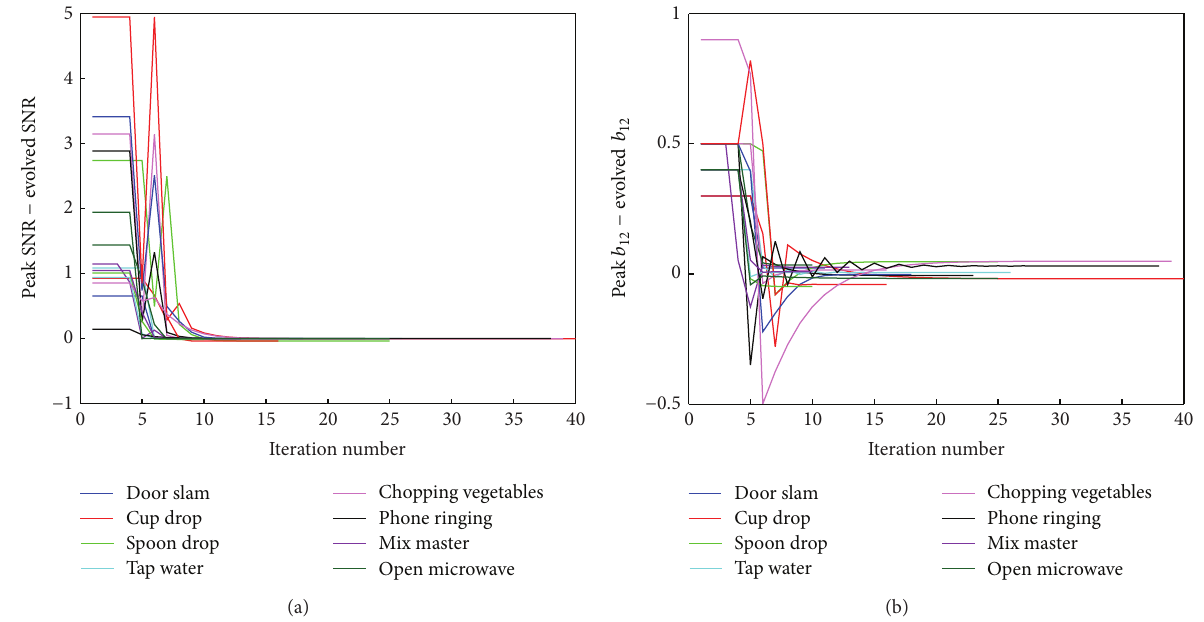
Figure 7: Difference between best SNR and evolved SNR (a) and best 𝑏 12 value minus evolved 𝑏 12 (b), for the database with a male speaker in the background, using microphones 1 and